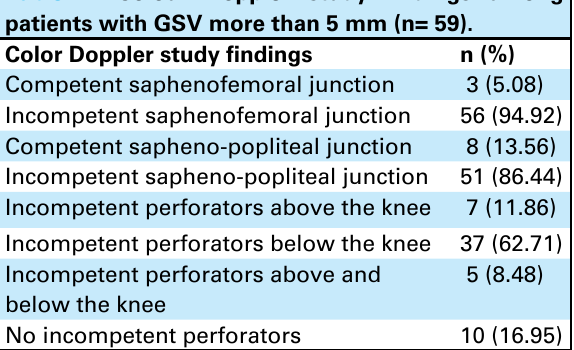
Table 4. Colour Doppler study findings among patients with GSV more than 5 mm (n=